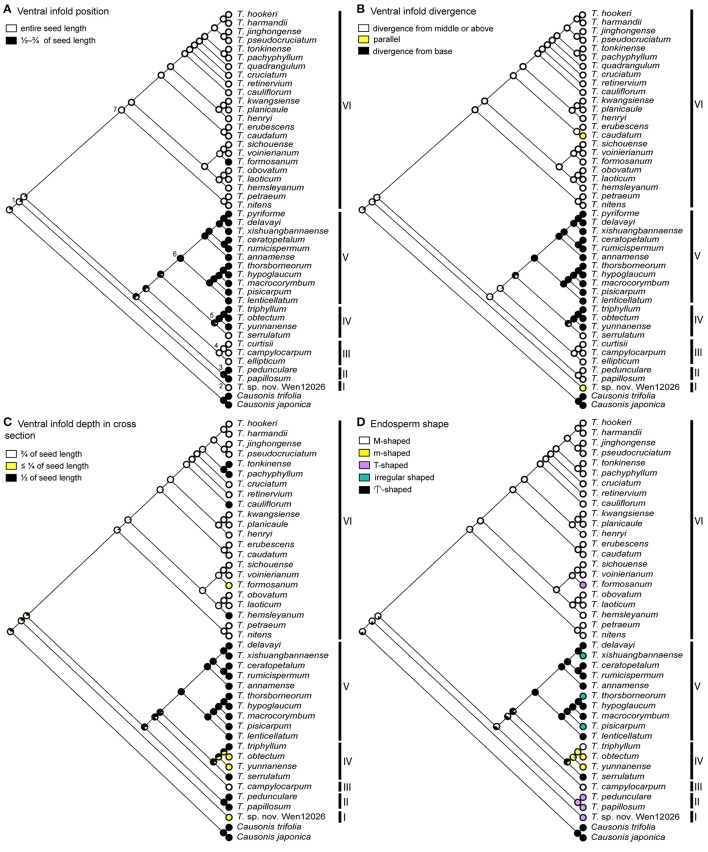
Optimization of key seed characters (5–8) based on Mk1 model implemented in Mesquite. (A) ventral infold position (character 5), and (B) ventral infold divergence (character 6) inferred on a 46-terminal ML tree. (C) Ventral infold depth in cross section (character 7), and (D) endosperm shape (character 8) inferred on a 42-terminal ML tree. Seven key nodes are marked in (A).